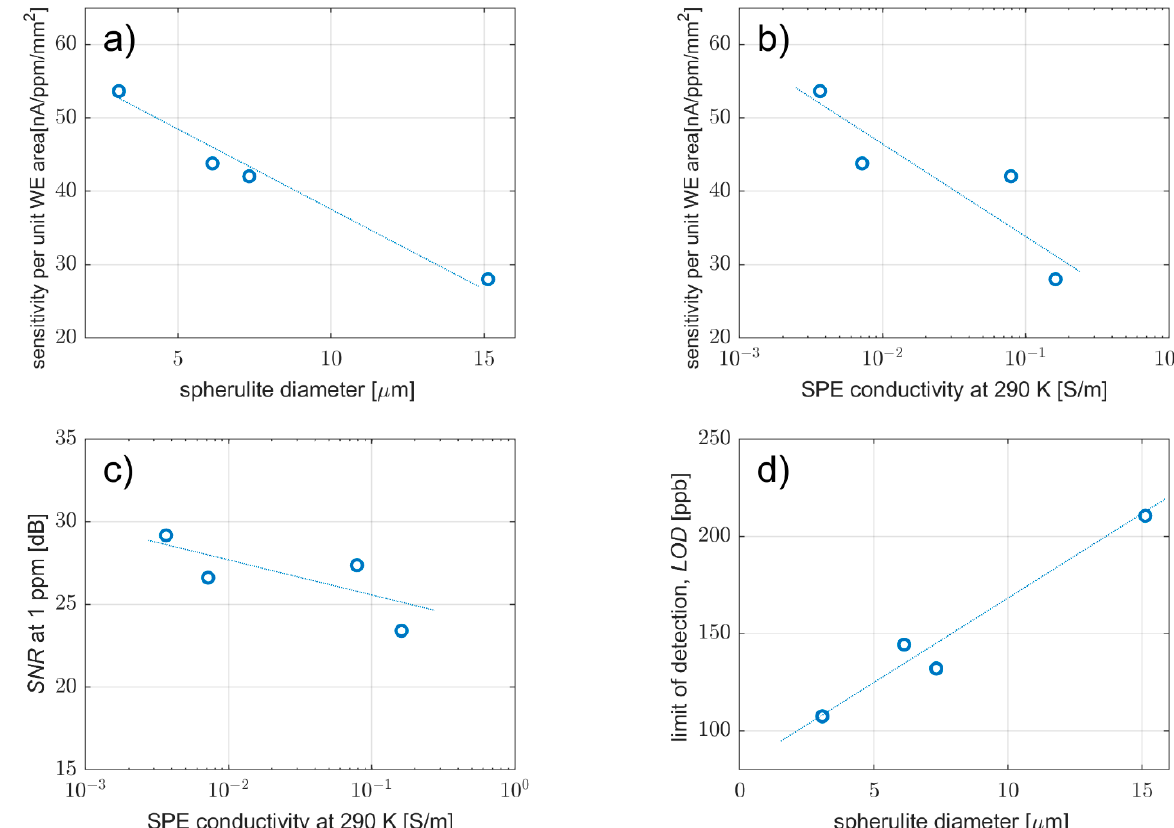
Figure 7. Effect on sensor properties of solvent evaporation rate from solid polymer electrolyte dur- ing preparation: ( a ) sensor sensitivity per unit WE area as a function of electrolyte-spherulite diameter, ( b ) sensor sensitivity per unit WE area as a function of electrolyte conductivity, ( c ) signal-to-noise ratio as a function of electrolyte conductivity, ( d ) limit-of-detection as a function of electrolyte-spherulite diameter.